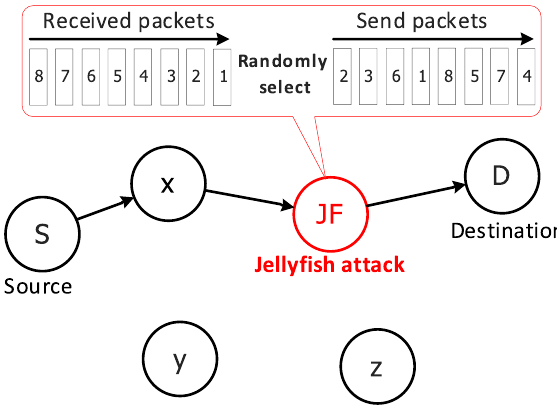
Figure 1. Jellyfish reordering attack.